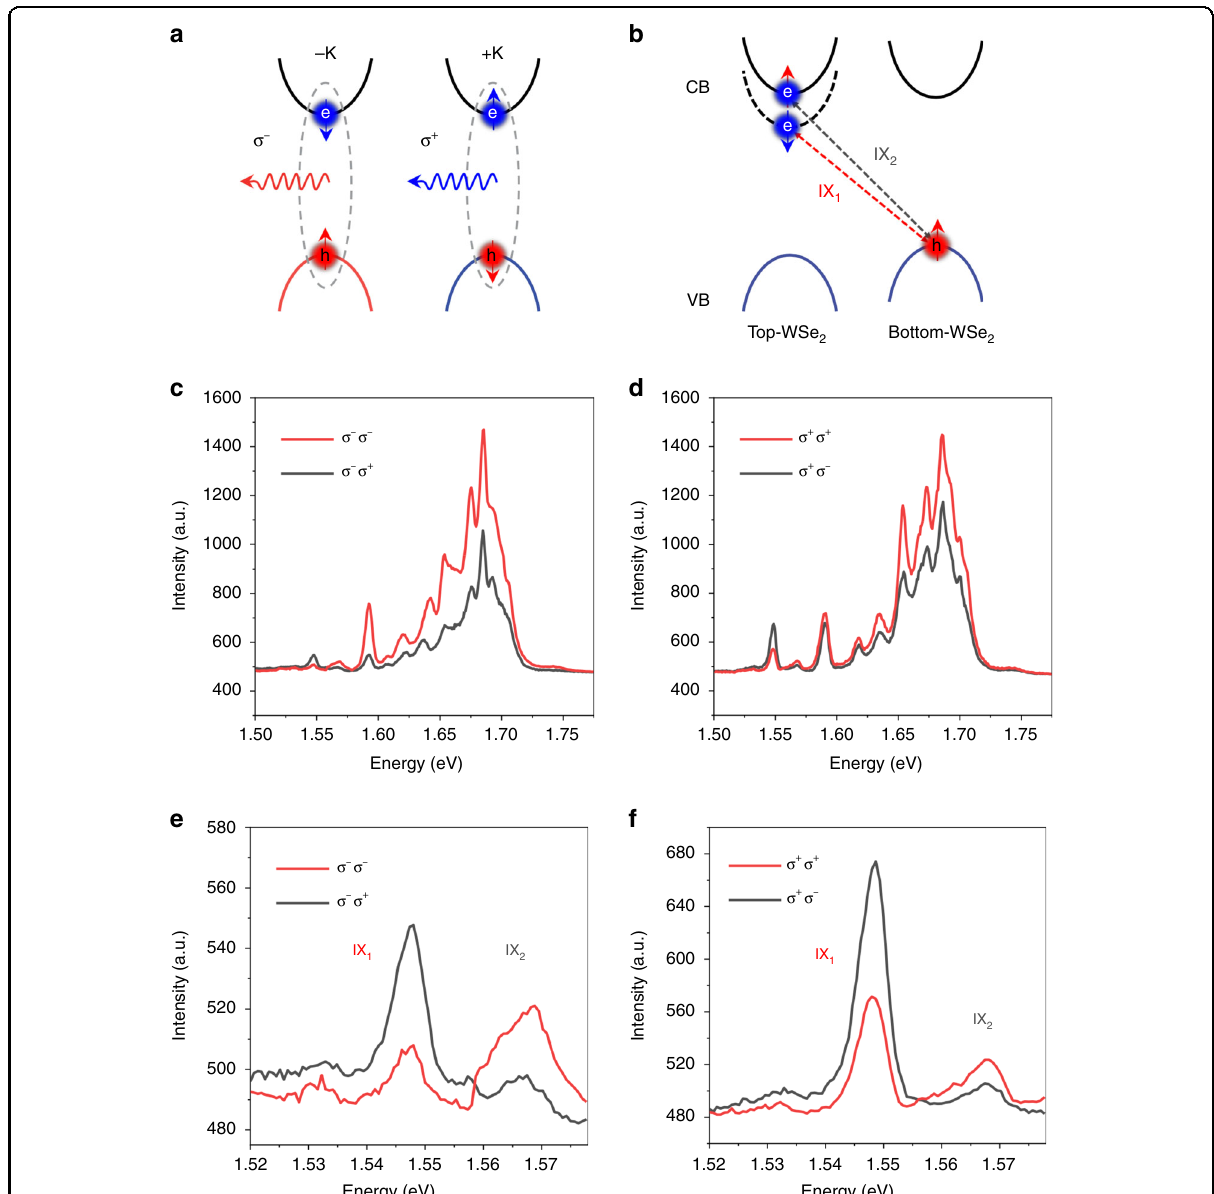
Fig. 5 Intralayer and interlayer excitons valley polarization in WSe 2 /WSe 2 twisted homobilayer. a Illustration of the valley optical selection rule, where the blue (red) sphere indicates electrons (holes) in the conduction (valence) band. The arrow represents spin up or down. The red (blue) wavy arrow indicates the emitted σ − ( σ + ) light. b illustration of interlayer excitons transition in the twisted WSe 2 /WSe 2 homobilayer. The red and gray dashed double arrows indicate the radiative recombination of the interlayer excitons IX 1 and IX 2 . c and d represent the circularly polarized PL spectra in the T-HB region under σ − and σ + excitation, respectively. e and f are the circularly polarized PL spectra of interlayer excitons under σ − and σ + excitation, respectively. The interlayer excitons appear opposite circular polarization. σ x σ y shows excitation with σ x pump and detection with σ y circular polarization. The measured temperature in ( c – f ) is 8